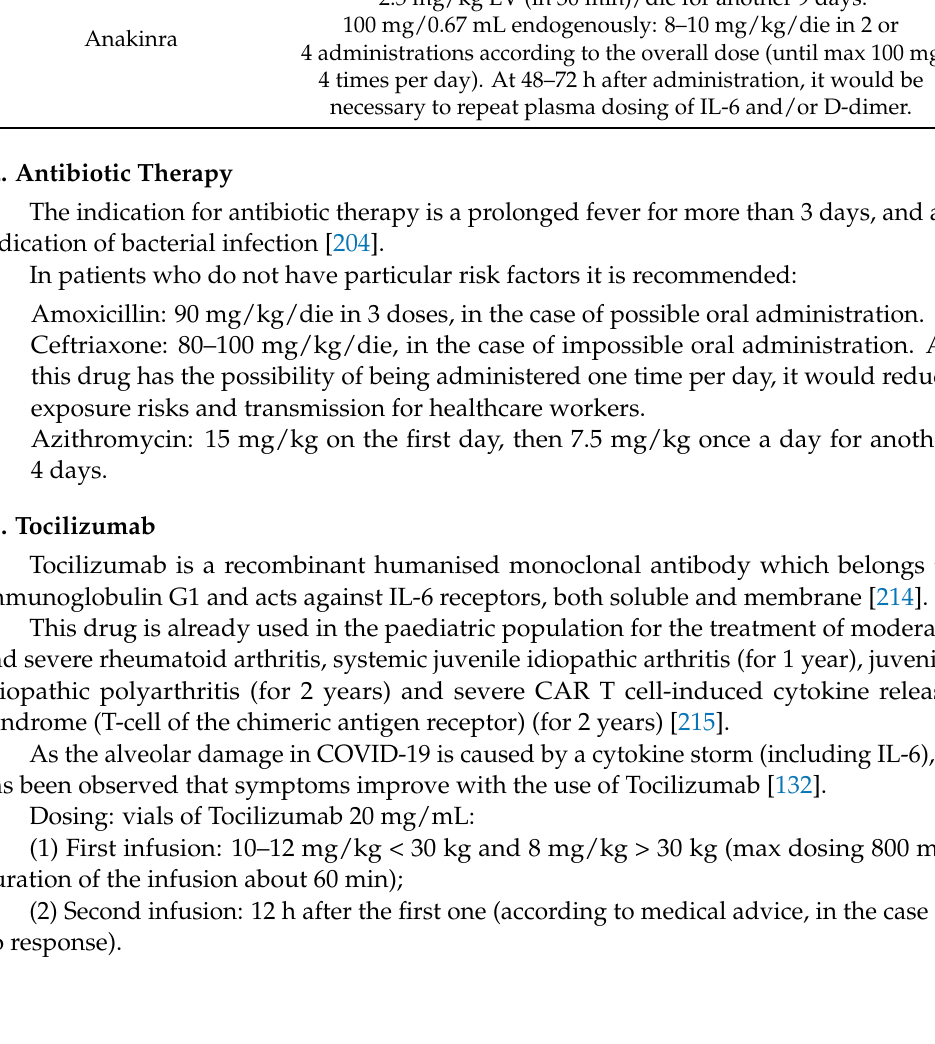
Table 7. Summary of COVID-19 Immunomodulant dosing. Antivirals